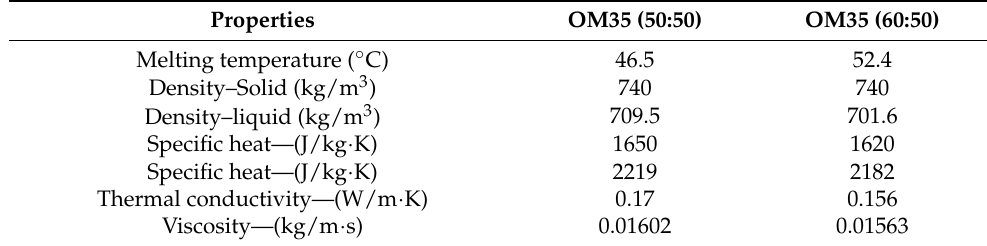
Table 3. Material properties of Phase change